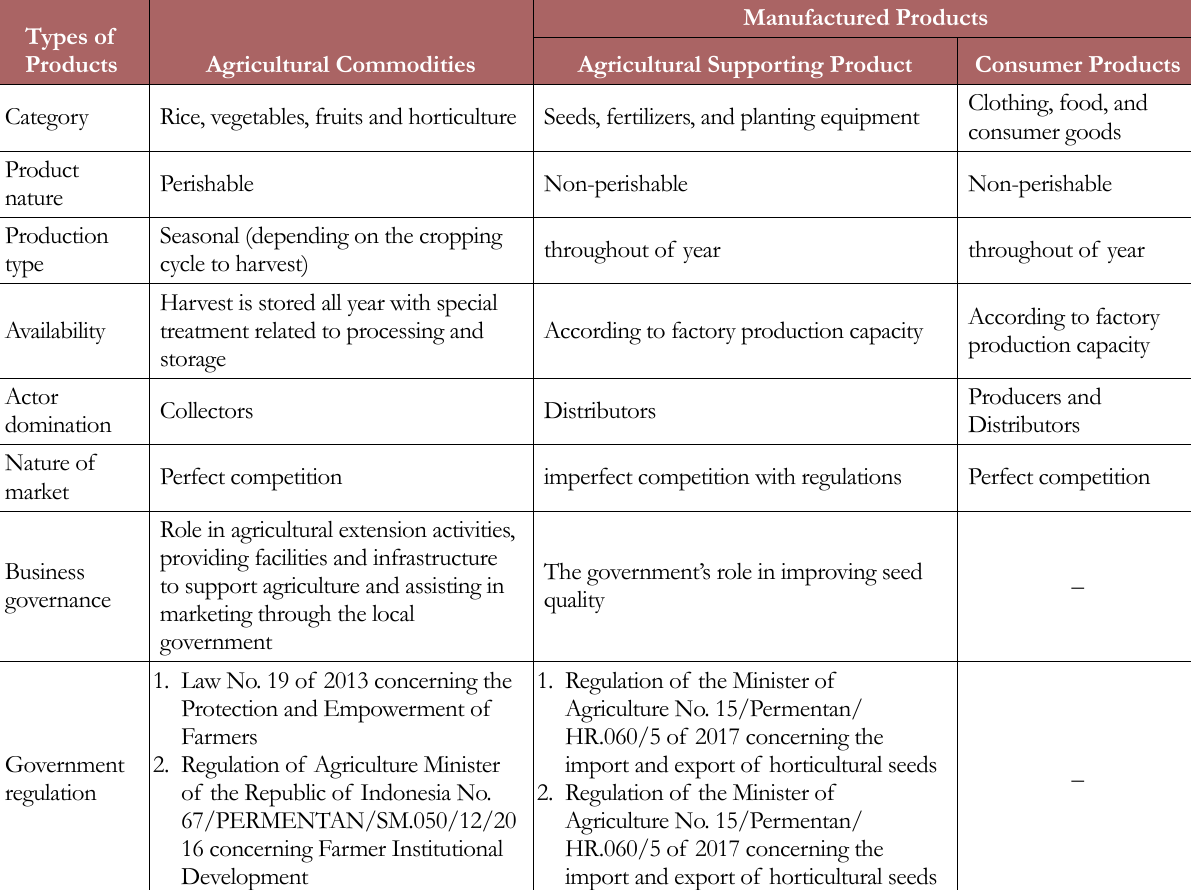
Table 3. Product description to be distributed in the rural logistics system Model